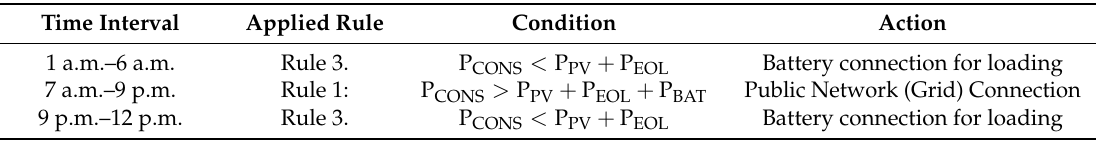
Table 3. Application of DSS decision rules on the pilot microgrid.